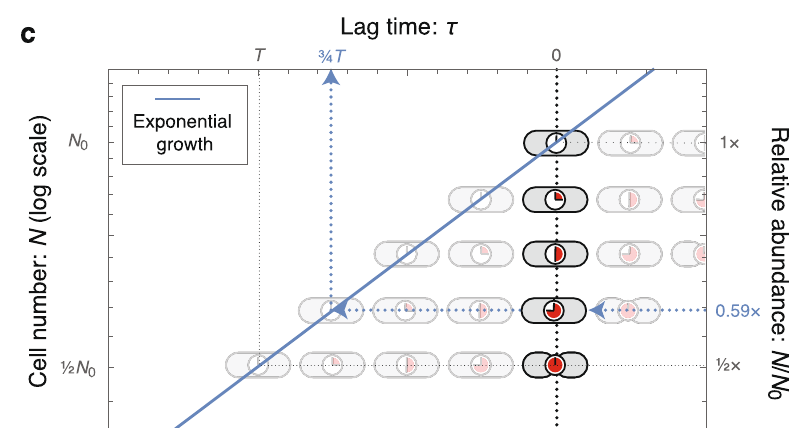
exponentially proliferating species that lags newborn cells by a time equal to its age. For instance, the nine-o'clock cell is at a relative abundance of 0.59 with a lag time of 3/4ths the mass-doubling time T . Schematically, start from the observed number of nine-o'clock cells, and follow that lineage horizontally (back in time) untilreachingthenewborncell,bornat t = t 0 − τ (bluedotted line).Forastochastic cell cycle, lag time measures the exponential mean of the stochastic time, Equation